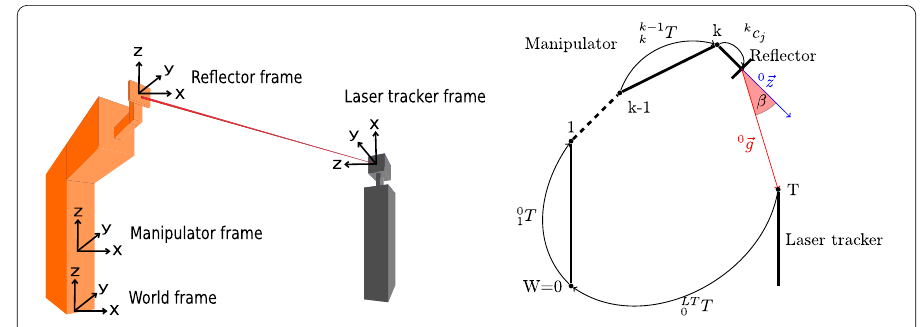
Figure 2 A laser tracker measurement system for parameter identification of industrial manipulators. On the left, a laser tracker with a single reflector is presented. Here, the world frame is located in the foot of the manipulator. On the right, the figure shows the homogeneous transformations describing the manipulator and the laser tracker as well as the transition from the laser tracker coordinate system to the world coordinate system LT 0 T . Transition from joint ( i – 1) to i is mathematically described by the homogeneous transformation i –1 i T . The reflector is mounted on the tool center point by the translation k c j . Incident angle β between the reflector’s orientation vector 0 z in z -direction and the normalized laser beam 0 g from the reflector to the laser tracker is computed by ( 0 z T · 0 g ) · (cid:6) 0 g (cid:6) .